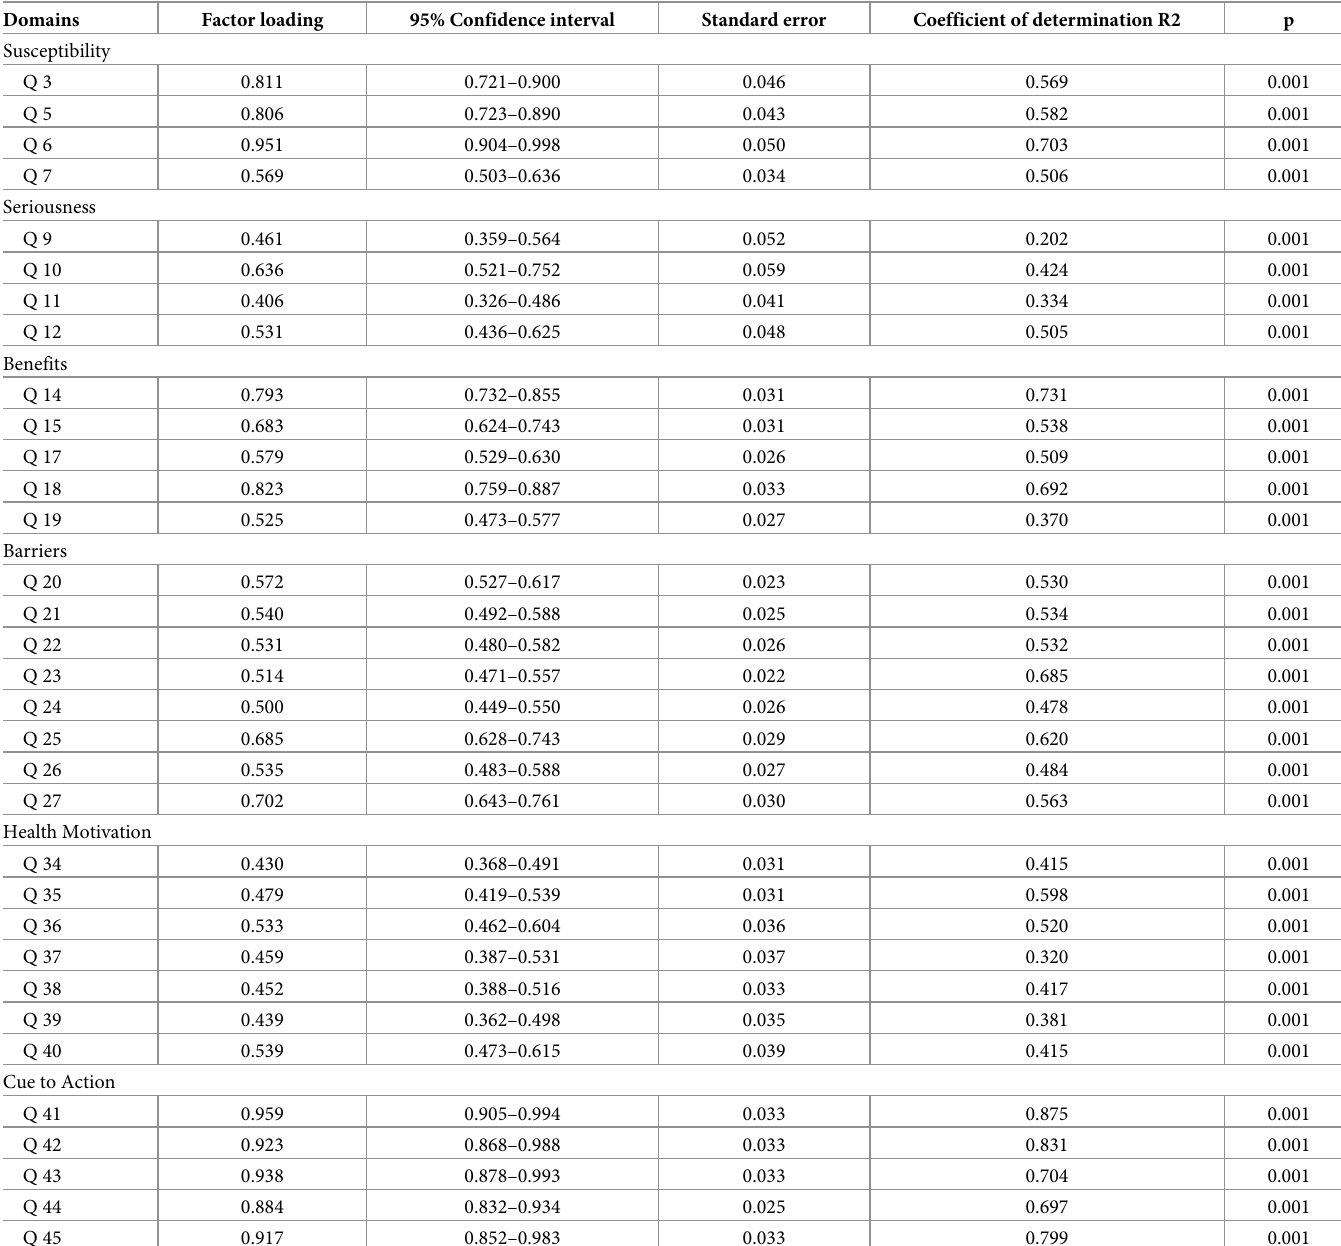
Table 4. Factor loadings and coefficient of determination for the modified Health Belief Model Applied to Influenza in Serbian language (Q—question).